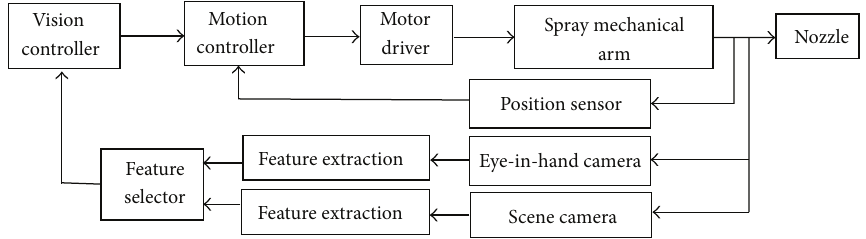
Figure 4: Block diagram of visual servo